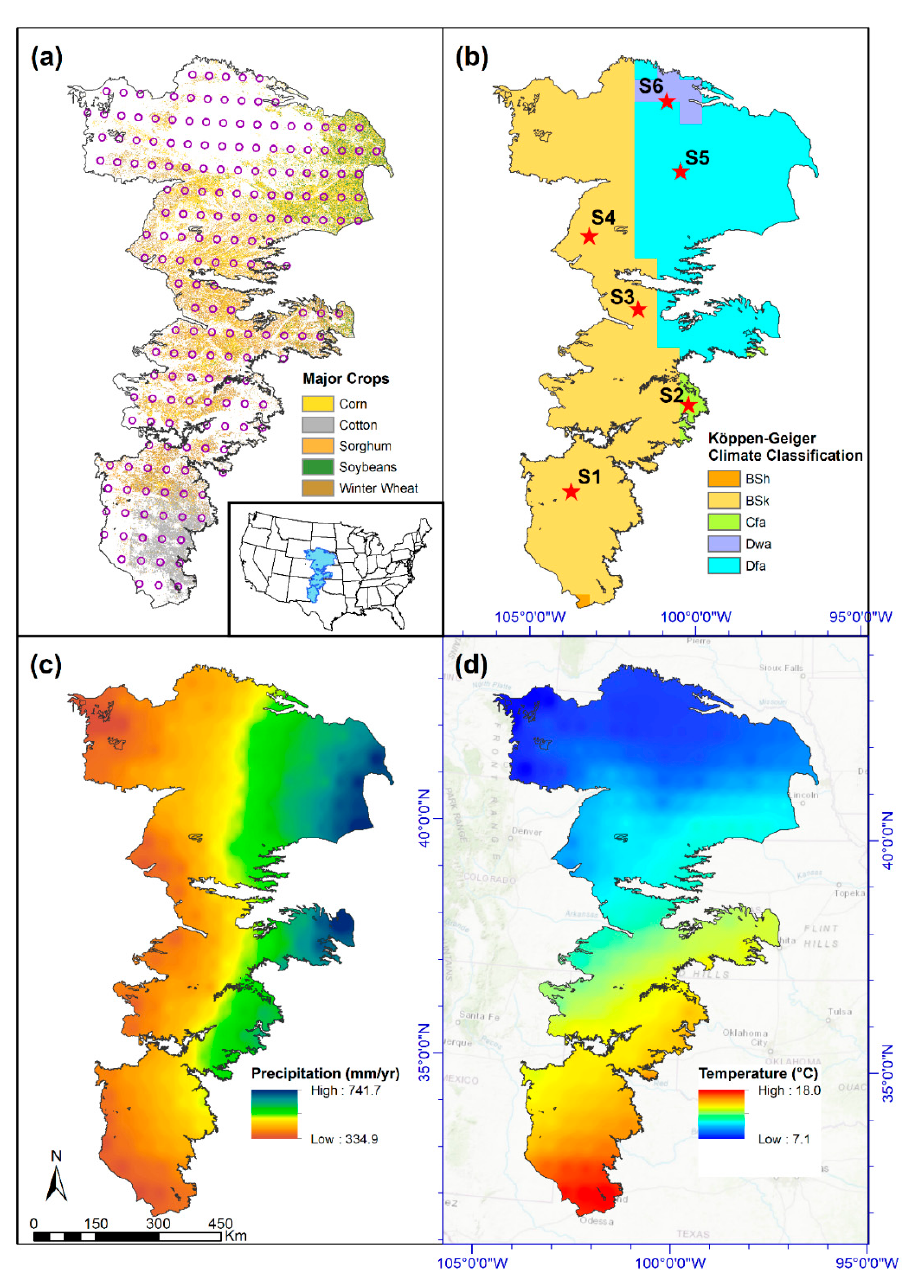
Figure 2. The Ogallala Aquifer characteristics—( a ) major crops and locations used in the model; ( b ) climate classes and representative sites used for illustration of site-specific data; ( c ) average annual precipitation, and ( d ) average annual temperature of the region.